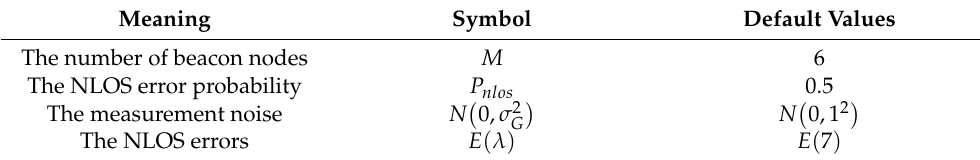
Figure 7. The CDF of the localization error. Table 3. Exponential distribution parameter.